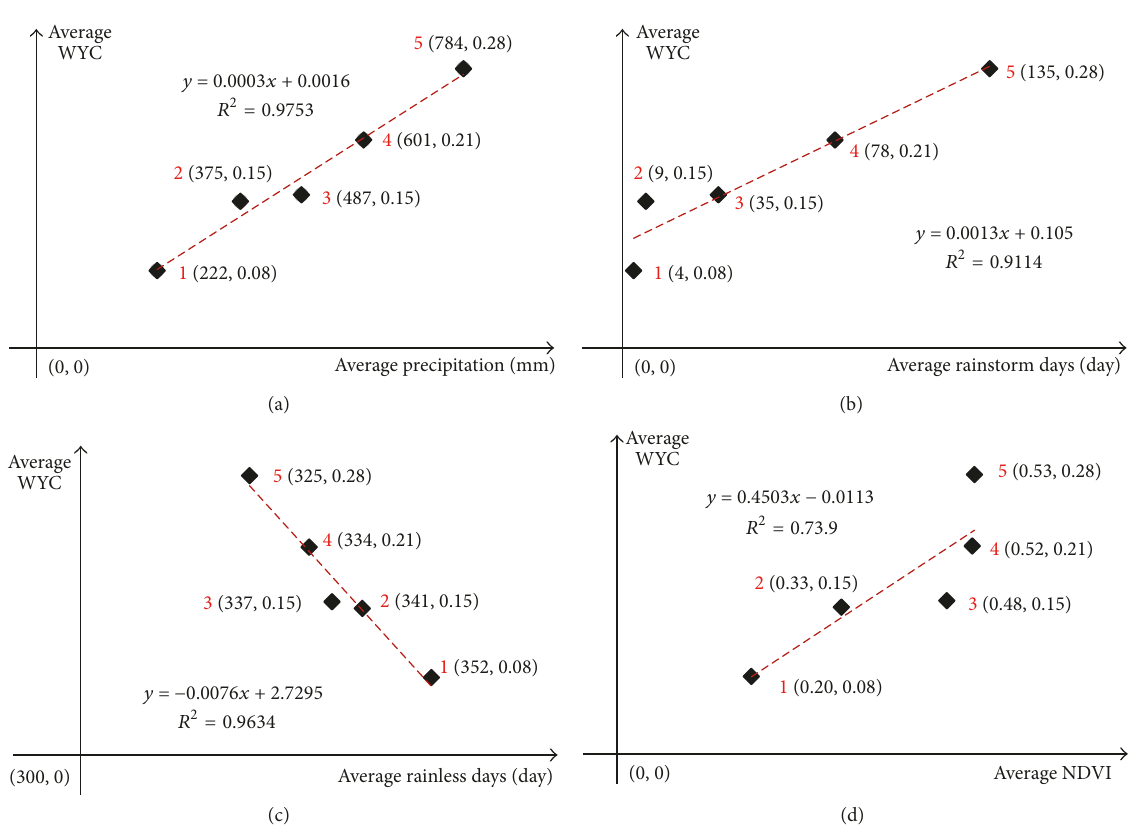
be 0.98, 0.91, 0.96, and 0.73, respectively. The correlation between the WYC and the precipitation characteristics is the largest, and the correlation between the WYC and the underlying surface conditions is relatively small. The WYC